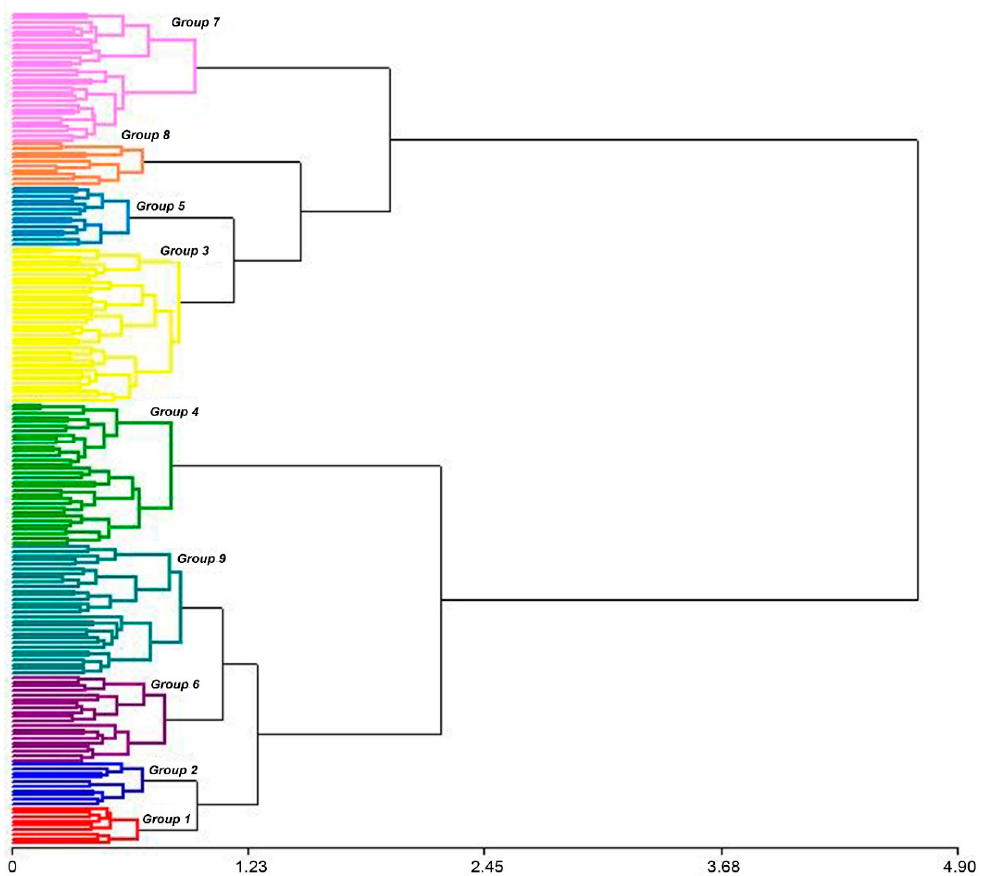
Figure 1. Dendrogram obtained by hierarchical cluster analysis (Ward’s method, Gower’s distance) with qualitative and quantitative variables from the morphological characterization of 192 accessions of chilli ( Capsicum spp.). Table 4. Description of the 9 groups of accessions from Figure 1, including species identification.